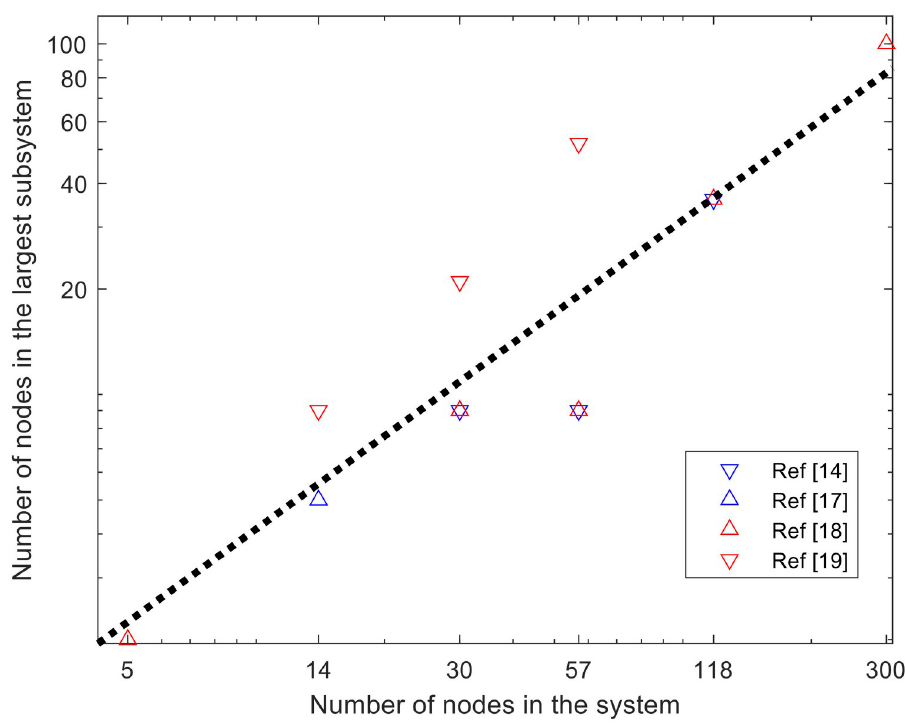
Fig 1. The largest number of nodes in the partitioned subsystems of various power system test cases reported in the literature [14, 17–19]. The dotted line indicates that the best linear fit for the relationship is N